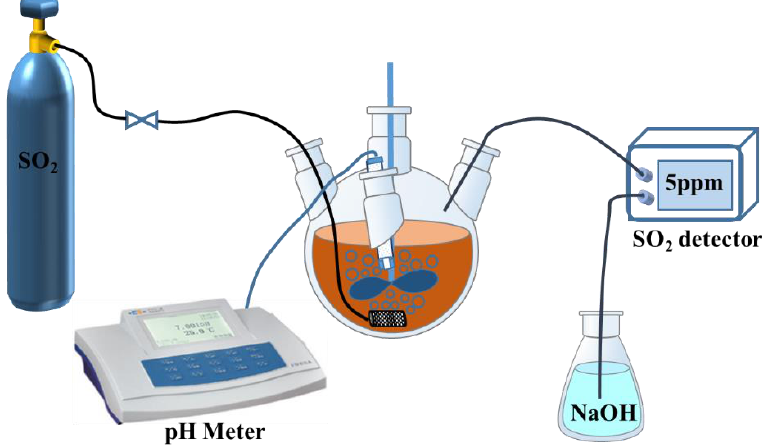
Figure 1. Experimental setup diagram.